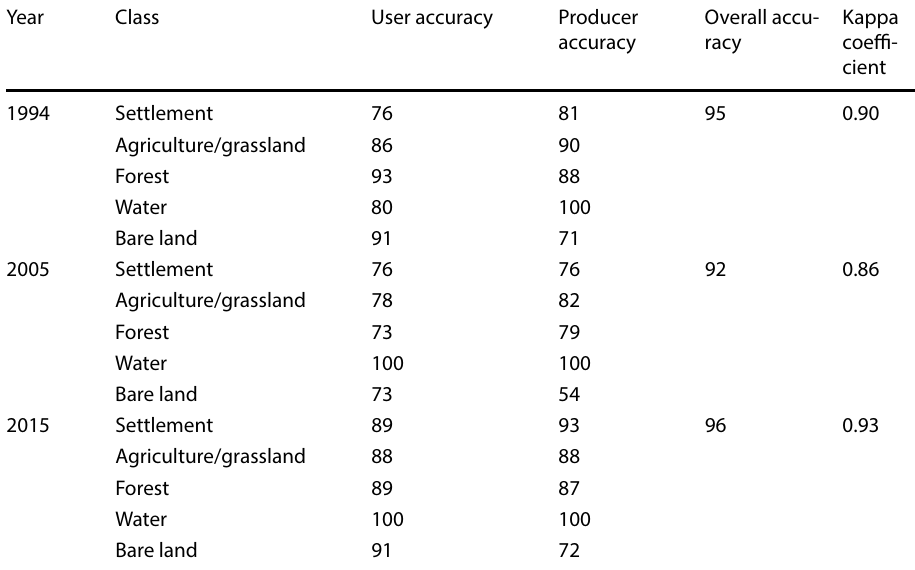
Table 3 Overall accuracy and kappa coefficient of land